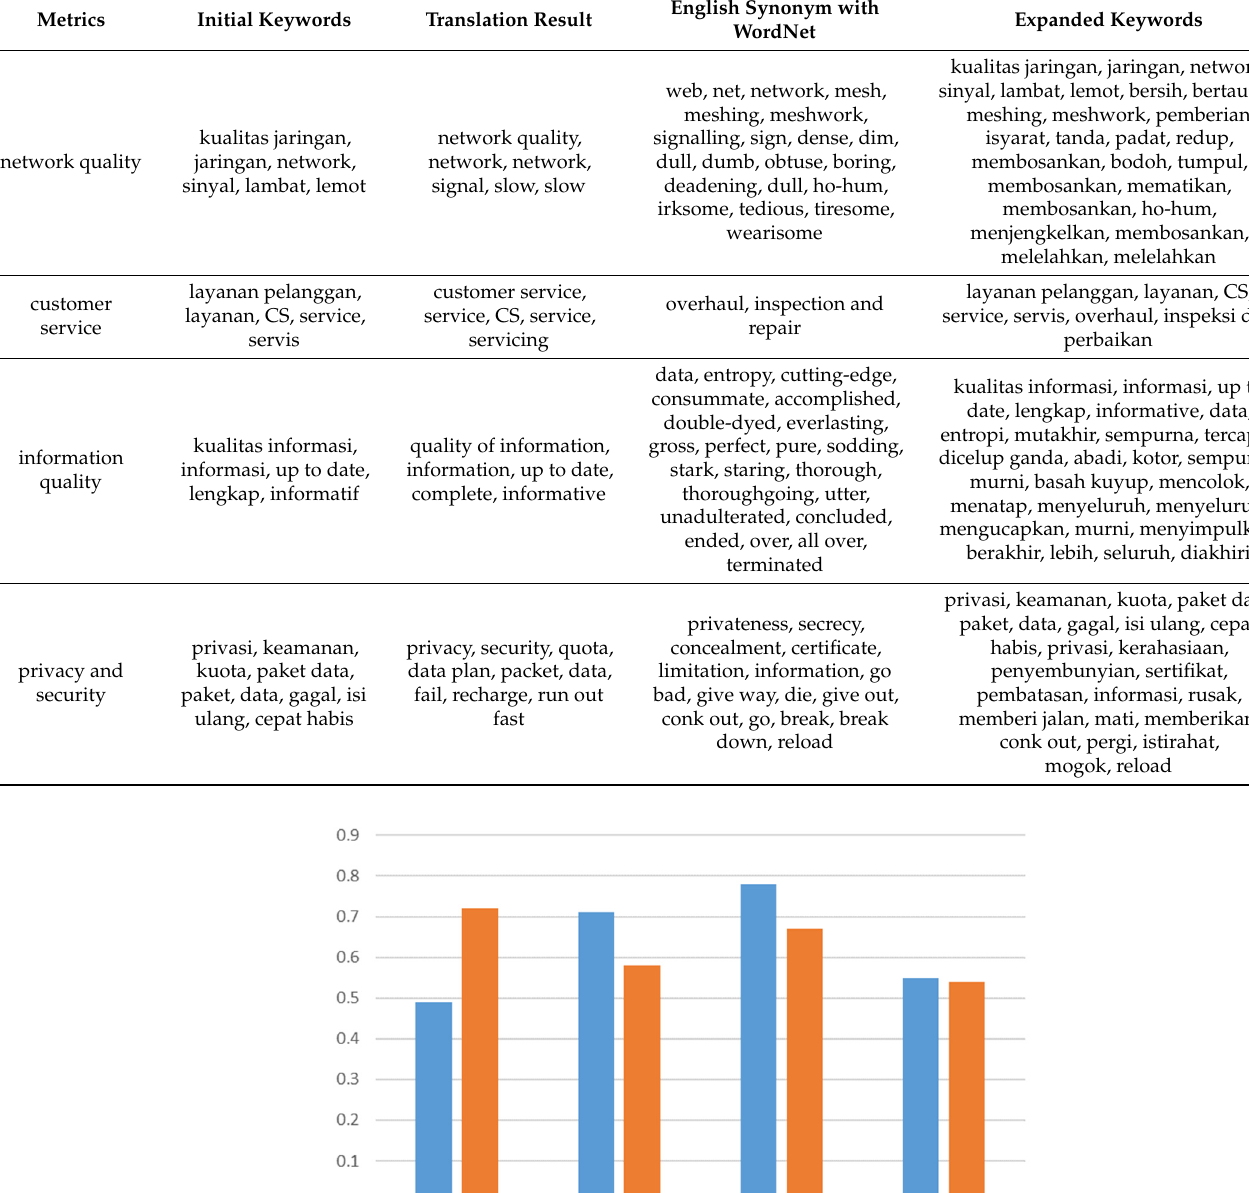
Table 6. The expanded keywords.